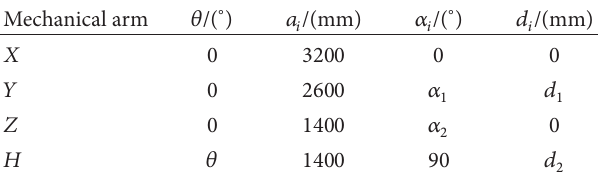
Table 1: D-H parameters of the glass-handing